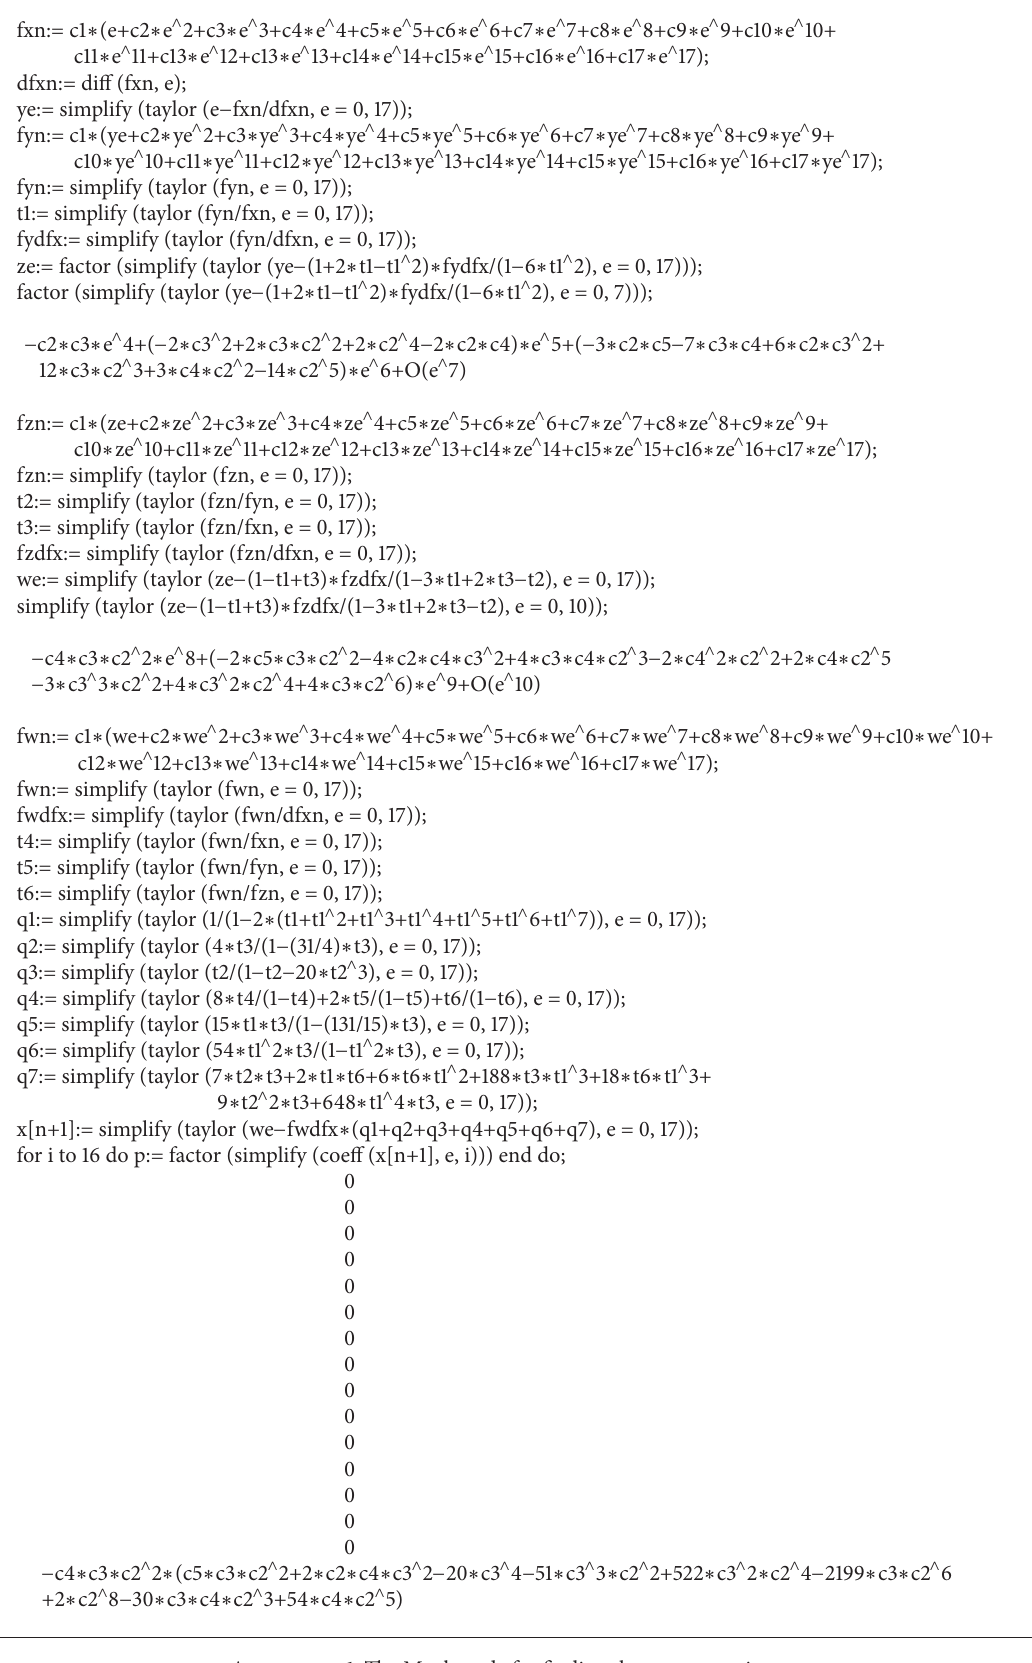
Algorithm 1: The Maple code for finding the error